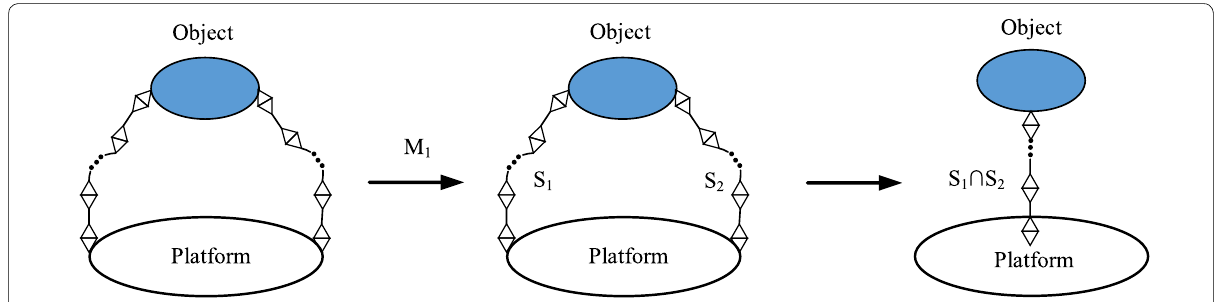
Figure 11 Schematic of chain decomposition with two